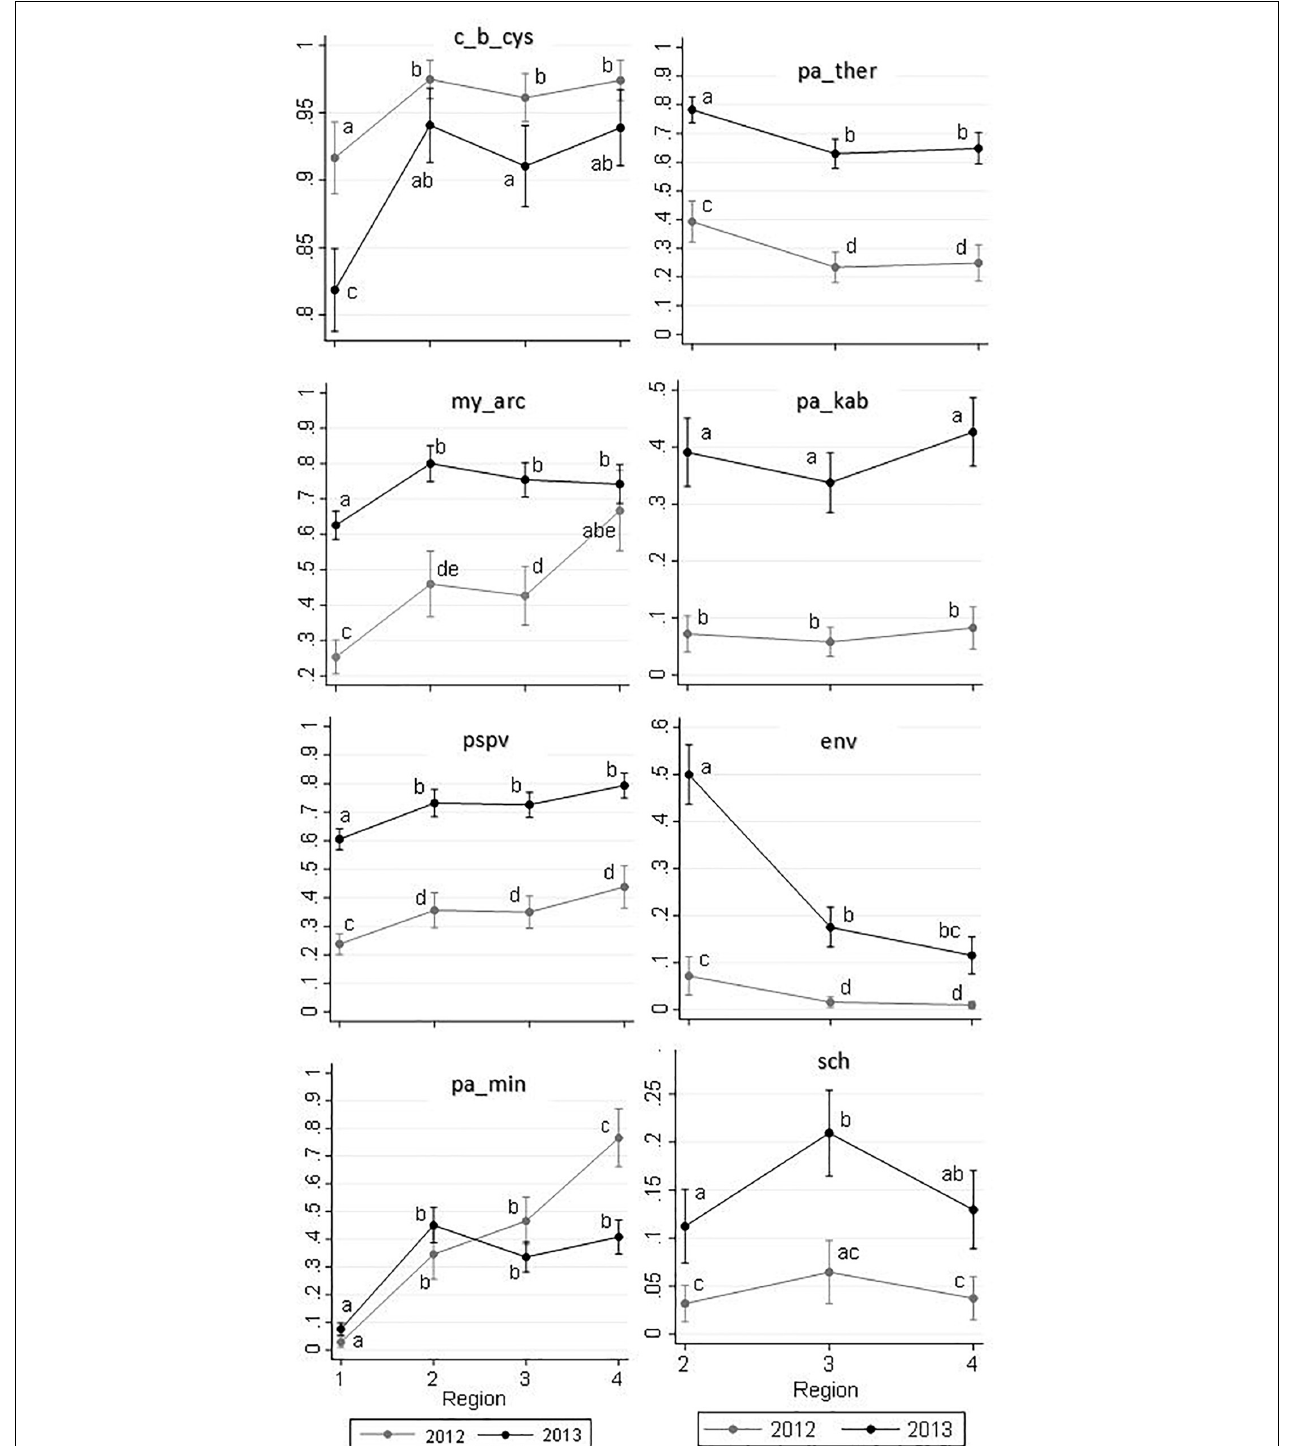
FIGURE 5 | Predicted probabilities of infectious agent detections ( Y -axes) in 2,006 Fraser River juvenile Sockeye salmon by sampling region ( X -axes) and year, based on logistic regression models. Sampling regions: (1) Freshwater, (2) Strait of Georgia, (3) Discovery Islands, and (4) Johnston Strait and north. Small letters used on the plots represent statistically significant Bonferroni groups, where differences were observed when the points (i.e., unique combinations of region and year) do not have any letters in common ( P < 0.05). If the points shared at least one letter with each other, they were not statistically different ( P > 0.05). Saltwater agents are presented in the right column, which included regions